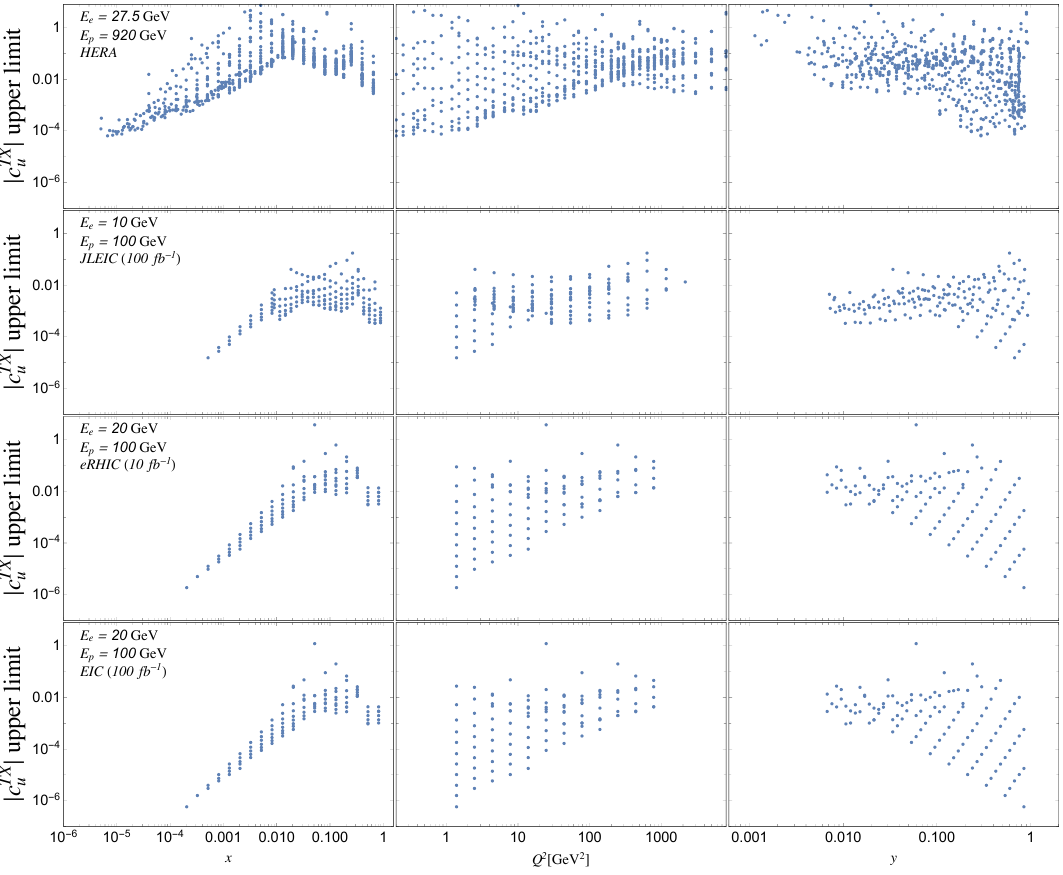
Figure 2 . Distribution of j c TX j correlated upper sensitivities for HERA and for JLEIC and eRHIC u in both initial and (cid:12)nal con(cid:12)gurations as functions of x , Q 2 and y related through Q 2 = xys .